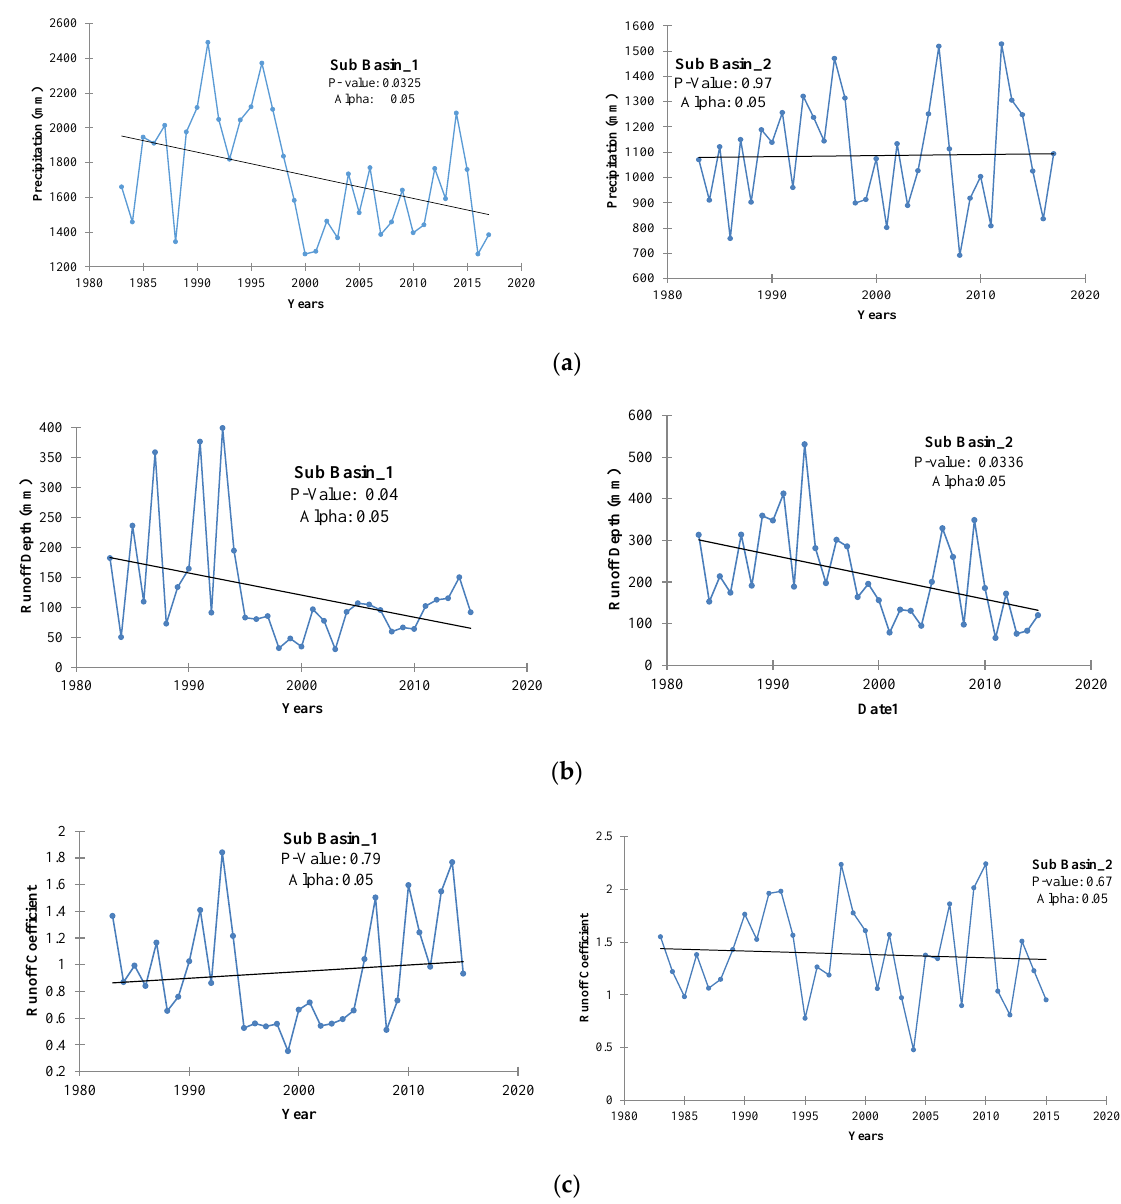
Figure 8. Temporal Variation of ( a ) Precipitation, ( b ) Runoff depth, and ( c ) Runoff Coefficient at sub-basin 1 and 2.